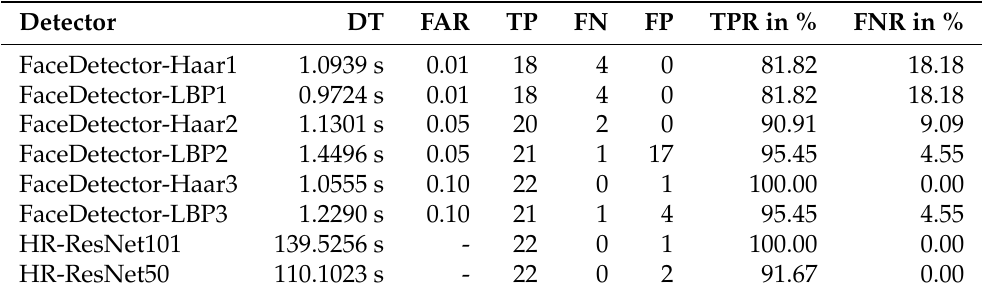
Table 1. Performance of custom trained Haar-like and LBP features for 0.01, 0.05, and 0.1 false alarm rate (FAR) values and six layers of